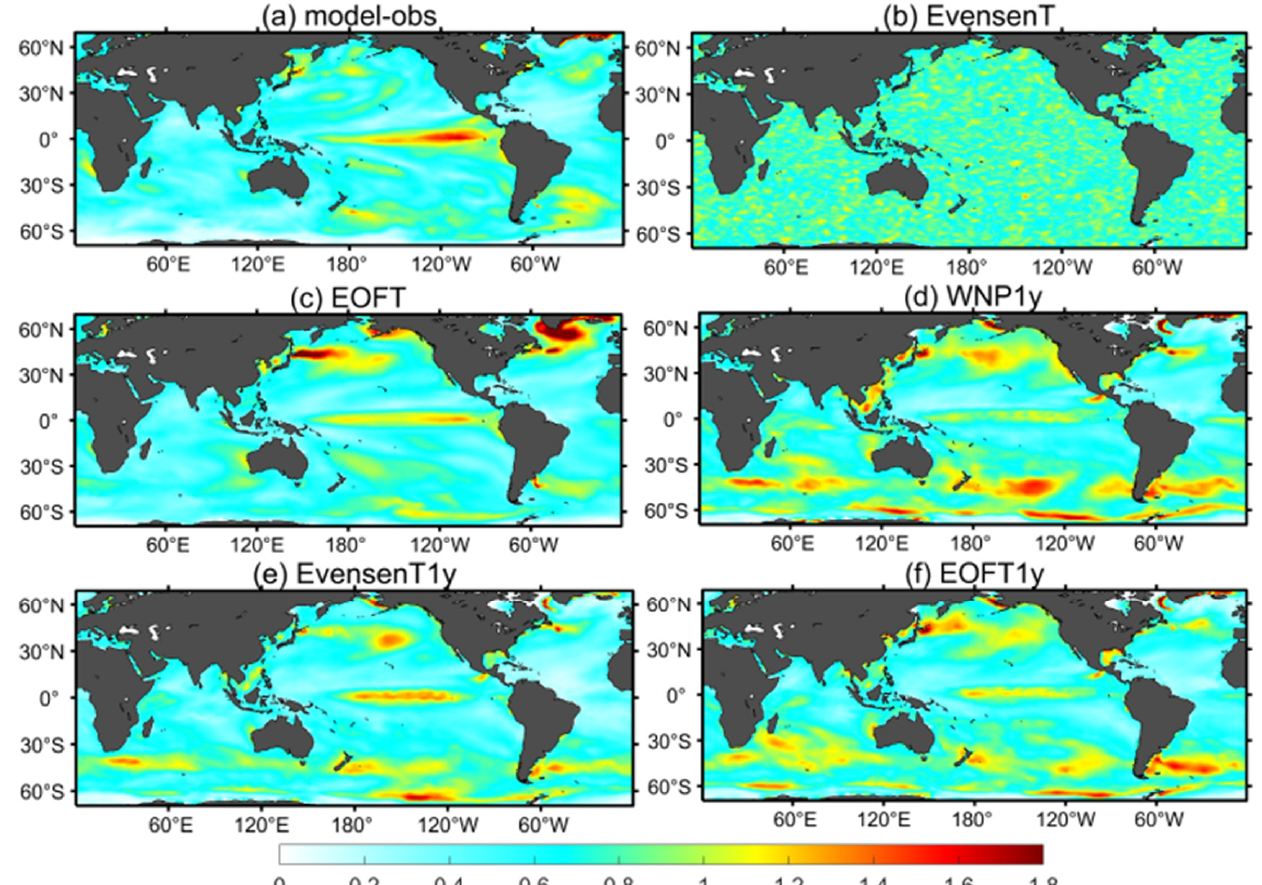
Figure 3. ( a ) SST RMSE (unit: °C)—time-mean CESM minus the “true SST”—over a 2-year period; SST standard deviation for the five experiments (unit: °C): ( b ) EvensenT experiment, ( c ) EOFT experiment, ( d ) WNP1y experiment, ( e ) EvensenT1y experiment, ( f ) EOFT1y experiment.